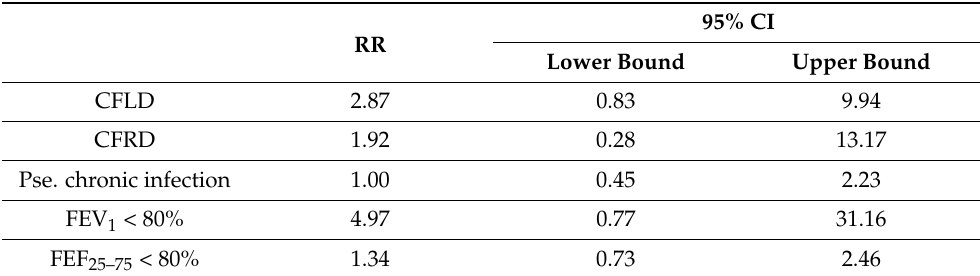
Table 3. Relative Risk for vitamin D < 30 ng/mL.